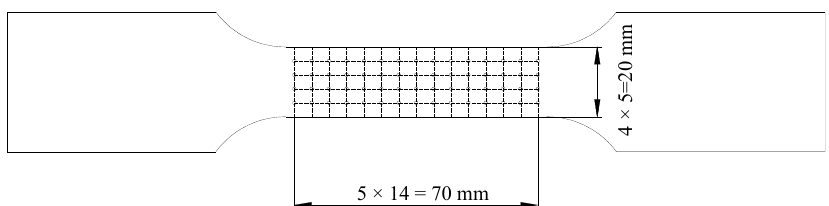
Figure 6. Measurement points. Table 3. The residual thickness of tensile samples.